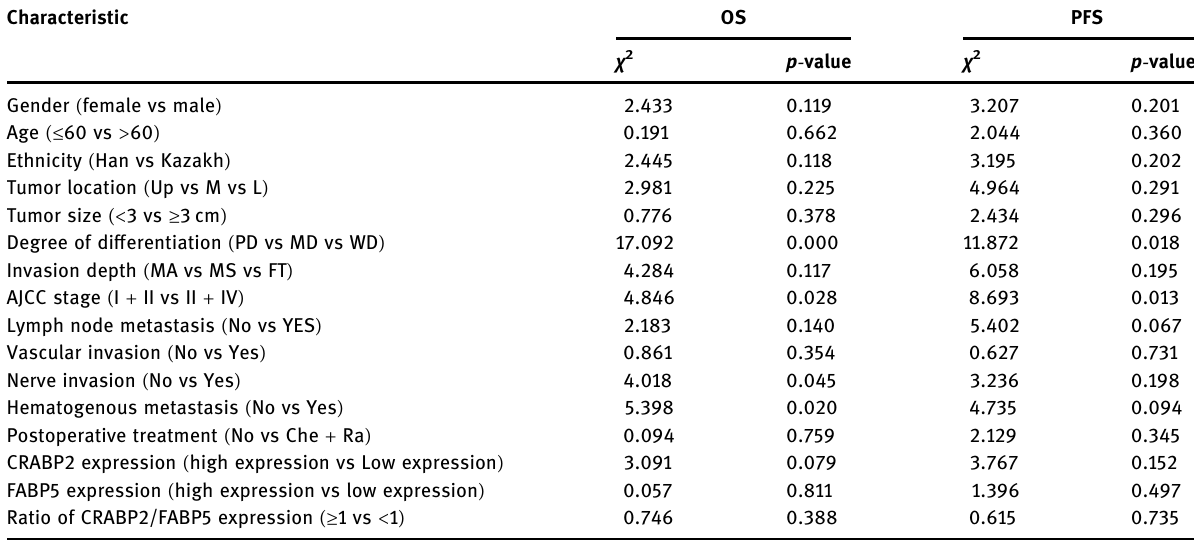
Table 5: Univariate analysis of factors associated with overall survival and progression - free survival in ESCC patients